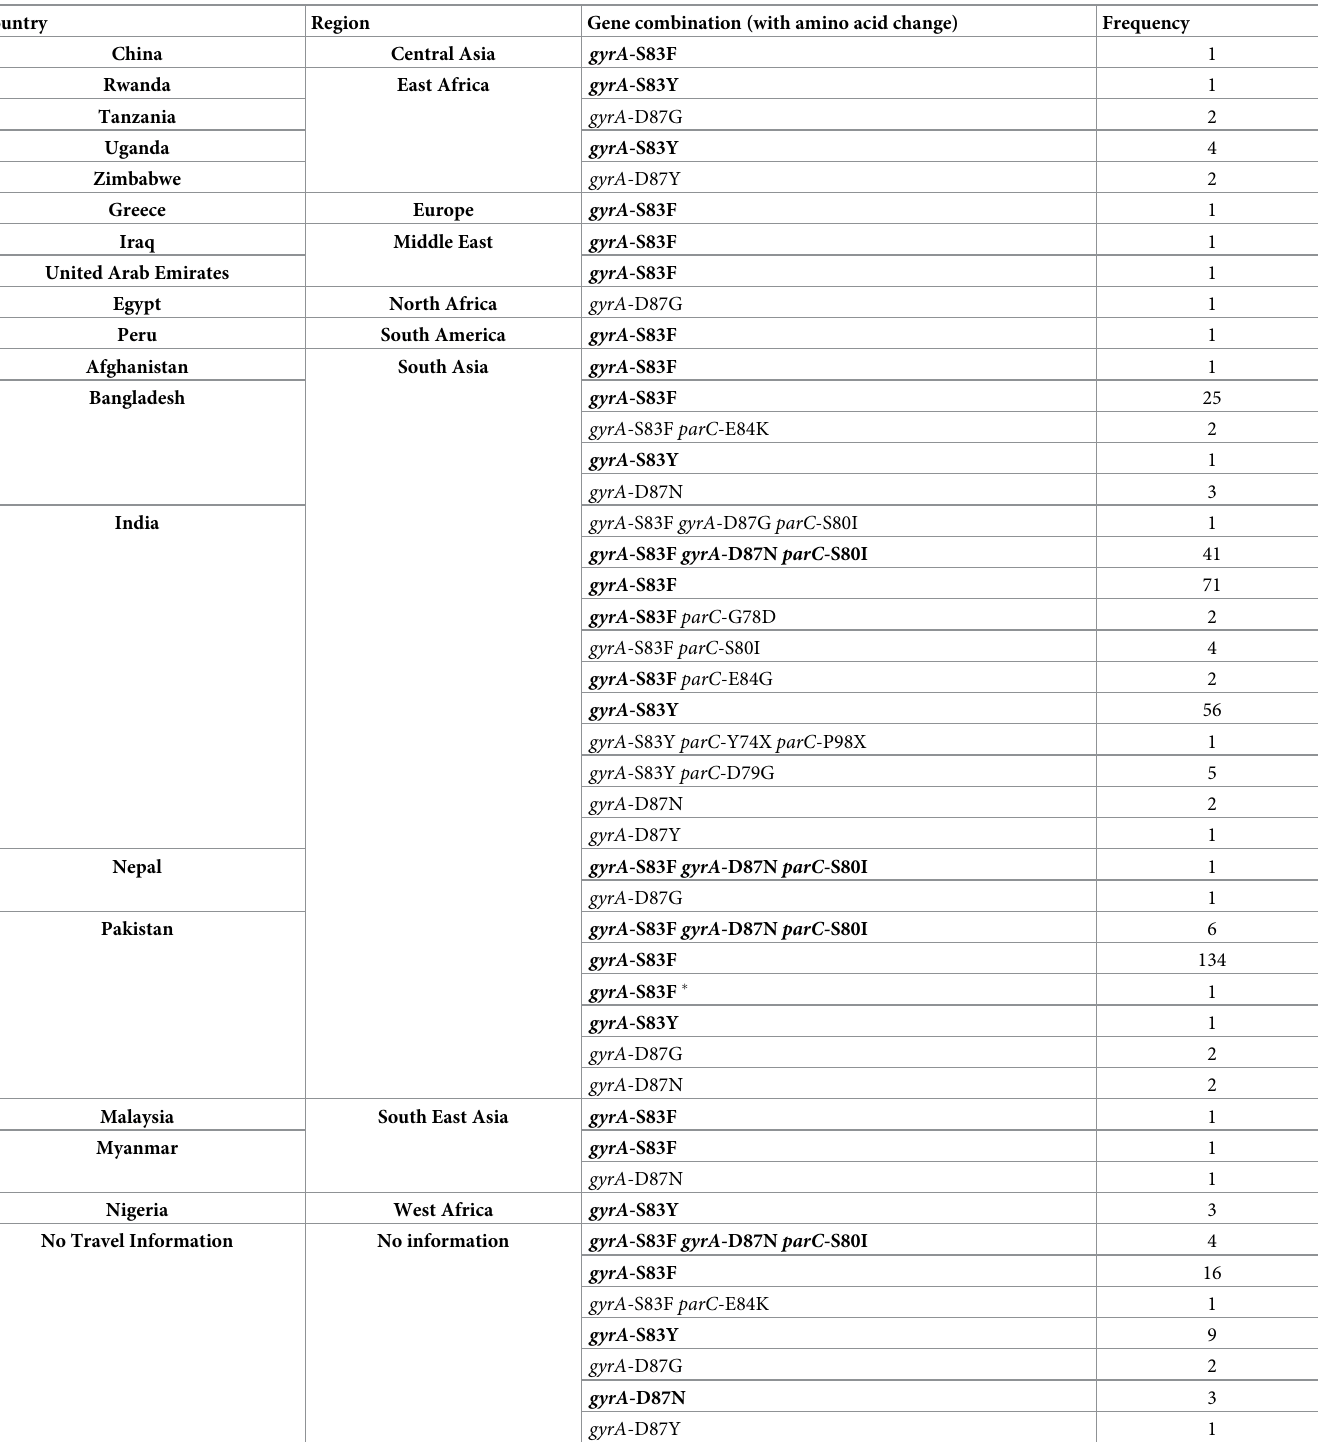
Table 2. Combinations of coding changes detected in the QRDR and their frequency by country of reported